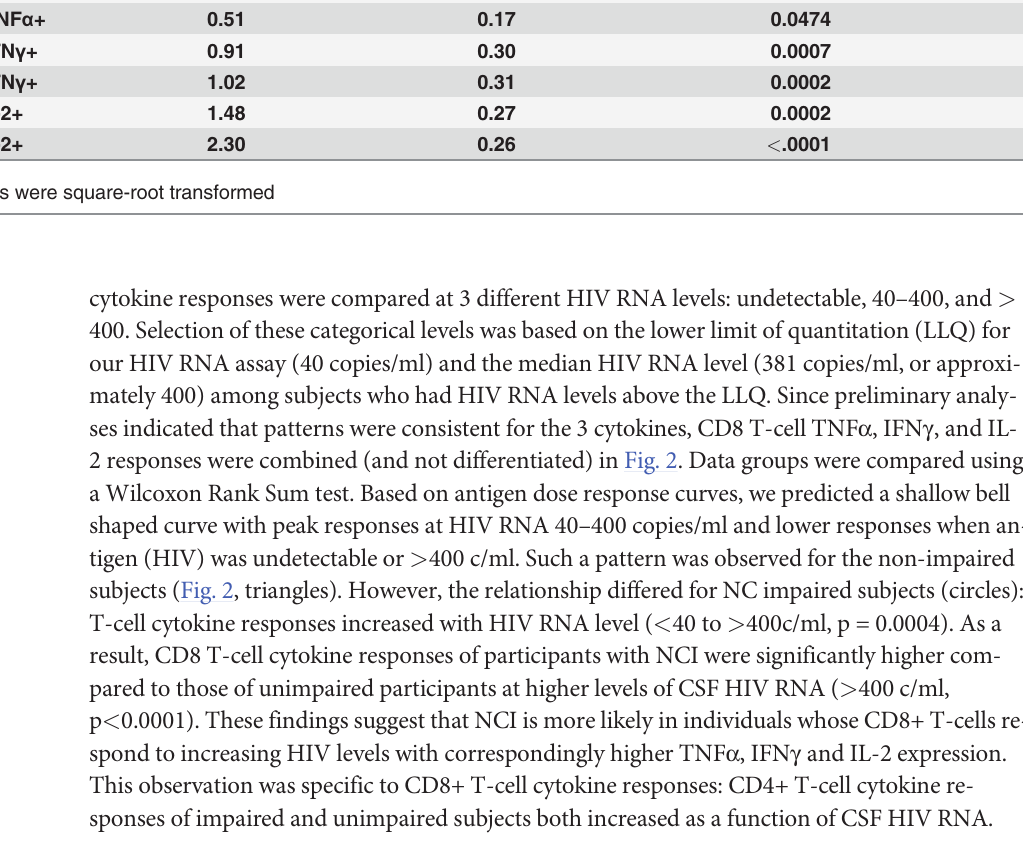
Table 2. T-cell cytokine expression is often higher in CSF than in peripheral blood.